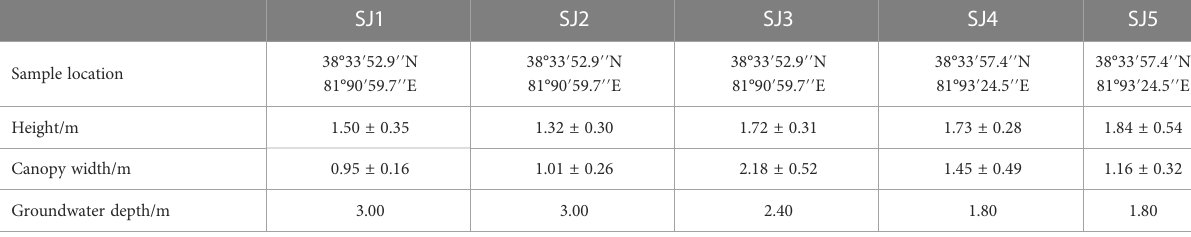
Values represent means ± SE. The abbreviations of the different habitats are the same as in Figure